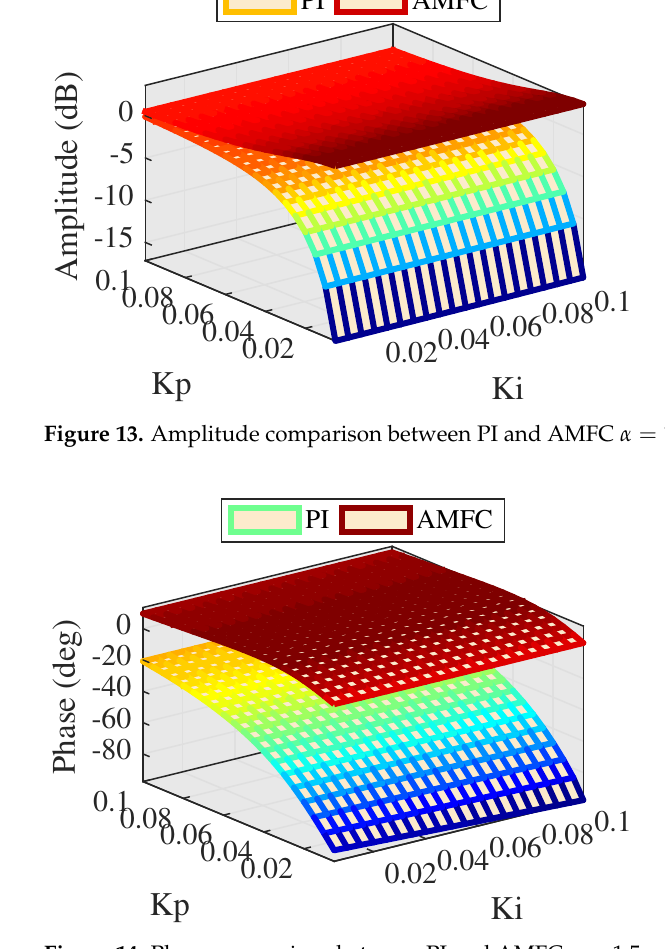
Figure 14. Phase comparison between PI and AMFC α =